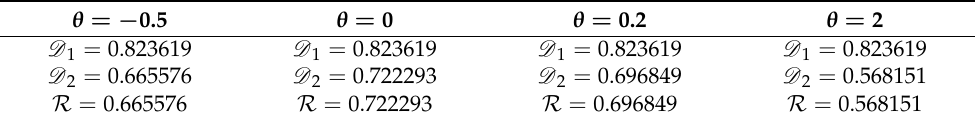
Table 1. Radii of convergence balls for Example 1.